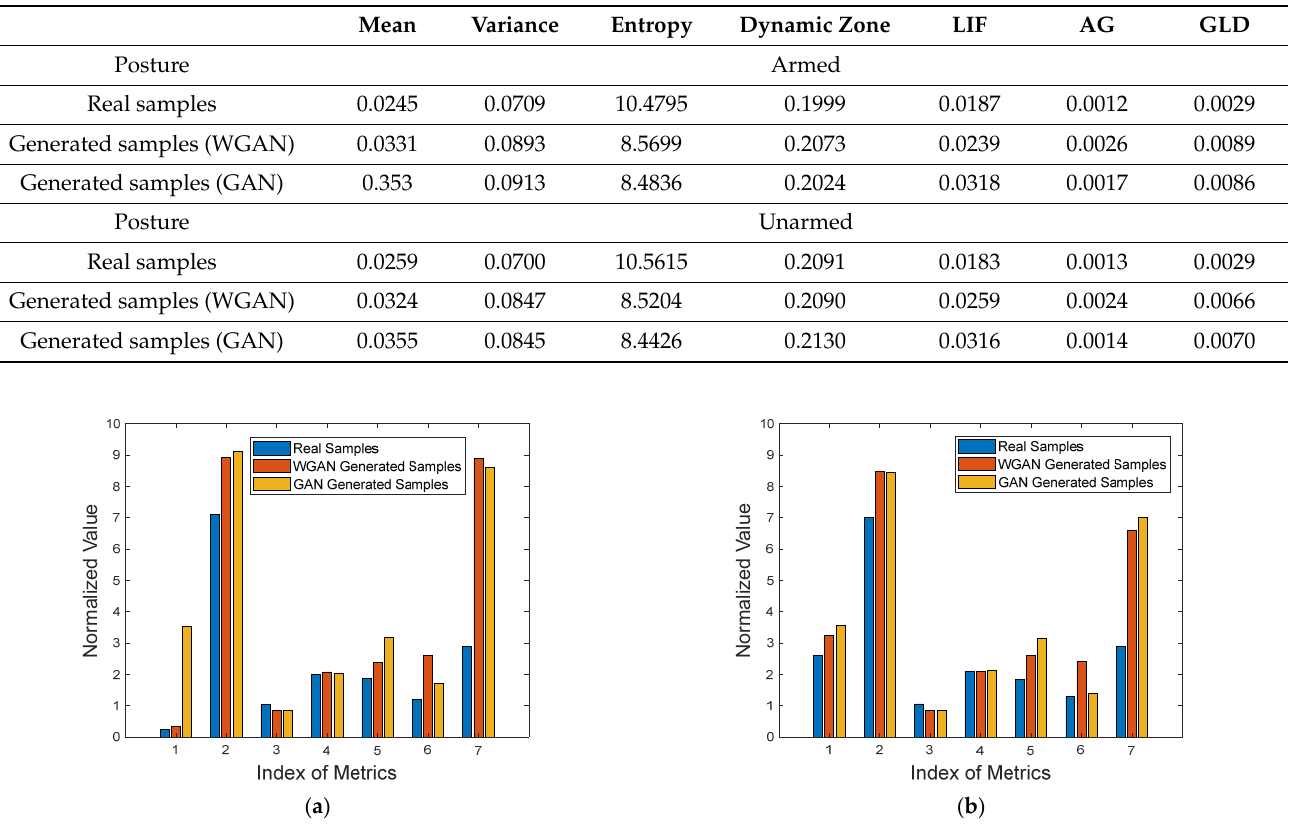
Figure 12. Bar graphs of the seven evaluation metrics of the generated samples from the database obtained using the modified Boulic model: ( a ) Armed pedestrian; ( b ) unarmed pedestrian.